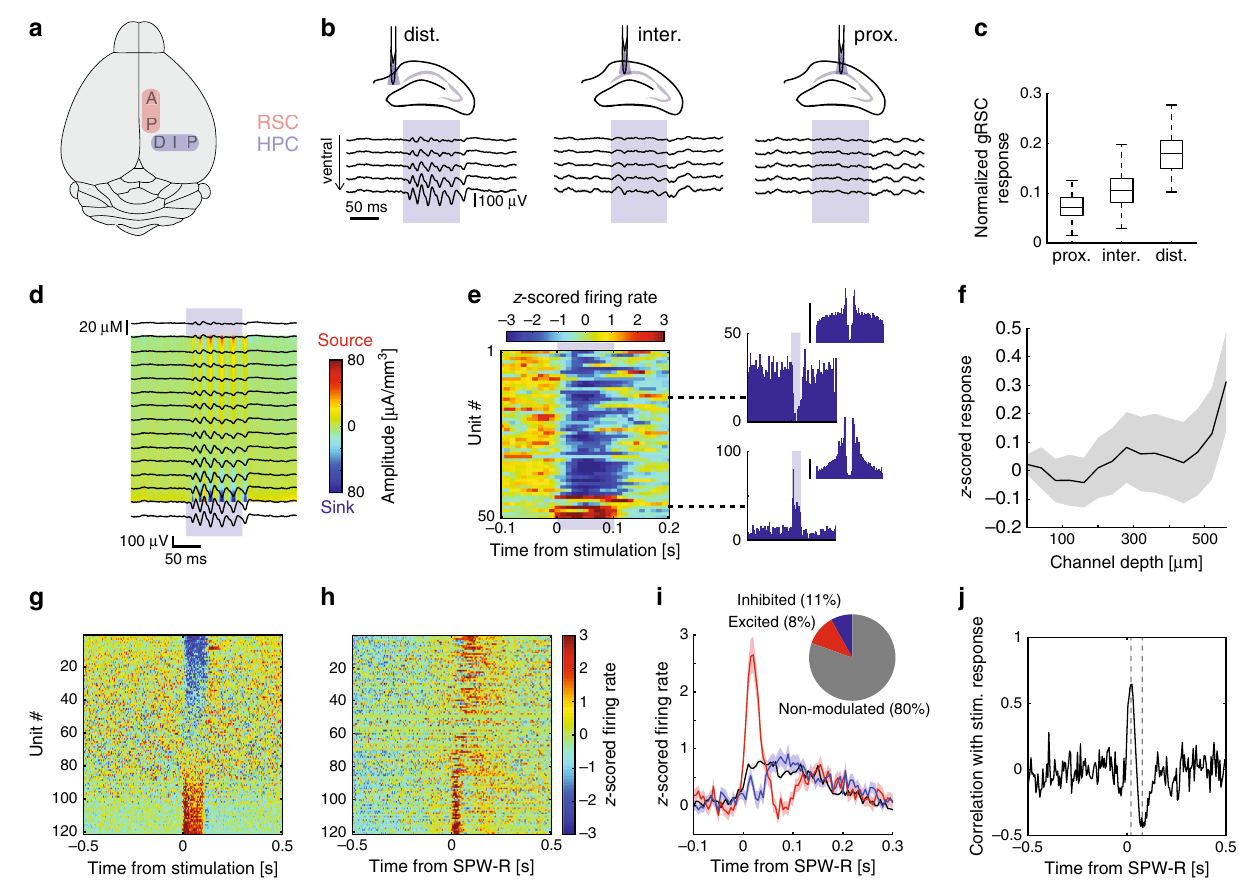
Fig. 4 Mapping of functional topography between dorsal hippocampus and gRSC in CaMKII-Cre::Ai32 mice. a Schematic depiction of probe placement. Two 8-shank probes were used to cover 1050 µ m of dorsal CA1 and subiculum medial-lateral axis and the gRSC anterior-posterior axis. b Voltage traces (mean ± s.e.m) from fi ve channels ranging from dorsal (top trace) to ventral (bottom trace) showing gRSC LFP responses to distal (left), intermediate (middle) and proximal (right) CA1 stimulation averaged over >300 events from one animal. c Normalized gRSC response to stimulation expressed as the ratio between local responses in CA1 and subiculum and evoked responses in the gRSC from one example animal ( n > 100 stimulations), plotted as a function of the location of stimulation along the proximal-distal axis of the dorsal hippocampus. Data are displayed as box plot representing median, lower and upper quartiles and whiskers representing most extreme data points. d CSD analysis of responses to distal CA1 stimulation and the corresponding voltage traces averaged over >300 events from one animal. e Left: Normalized raster plot of gRSC unit fi ring in response to distal CA1 stimulation from one shank, sorted based on the location of maximal waveform amplitude. Right: individual examples of a deep inhibited pyramid (top) and a super fi cial excited pyramid (bottom). Y -axis, spike count; scale bar, 5 Hz. f Summary of z-scored fi ring responses to distal CA1 stimulation as a function of maximal waveform depth (mean ± s.e.m., n = 3 sessions from three animals). g Z-score normalized responses of gRSC units signi fi cantly modulated by CA1 stimulation sorted based on response magnitude. h Z-score normalized responses of gRSC units to CA1 SPW-Rs sorted as in ( g ). i Averaged z-scored fi ring rate in response to stimulation of gRSC units which are positively (red), negatively (blue) or not modulated (black, not shown in ( g ) and ( h )) by hippocampal stimulation (mean ± s.e.m; n = 619 units from three mice and three sessions). Inset, proportions of each group. j Firing time from SPW-R onset is correlated with response magnitude. Dashed gray lines mark maximal and minimal